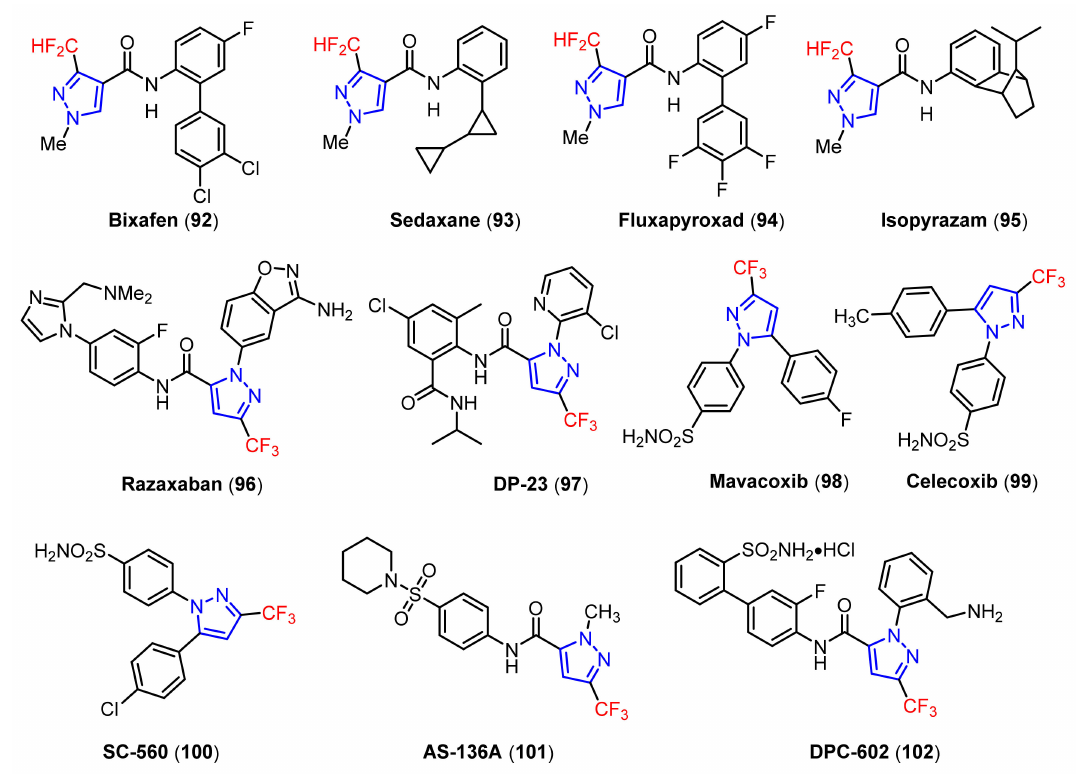
Figure 4. Examples of bioactive molecules with fluorine-containing pyrazole